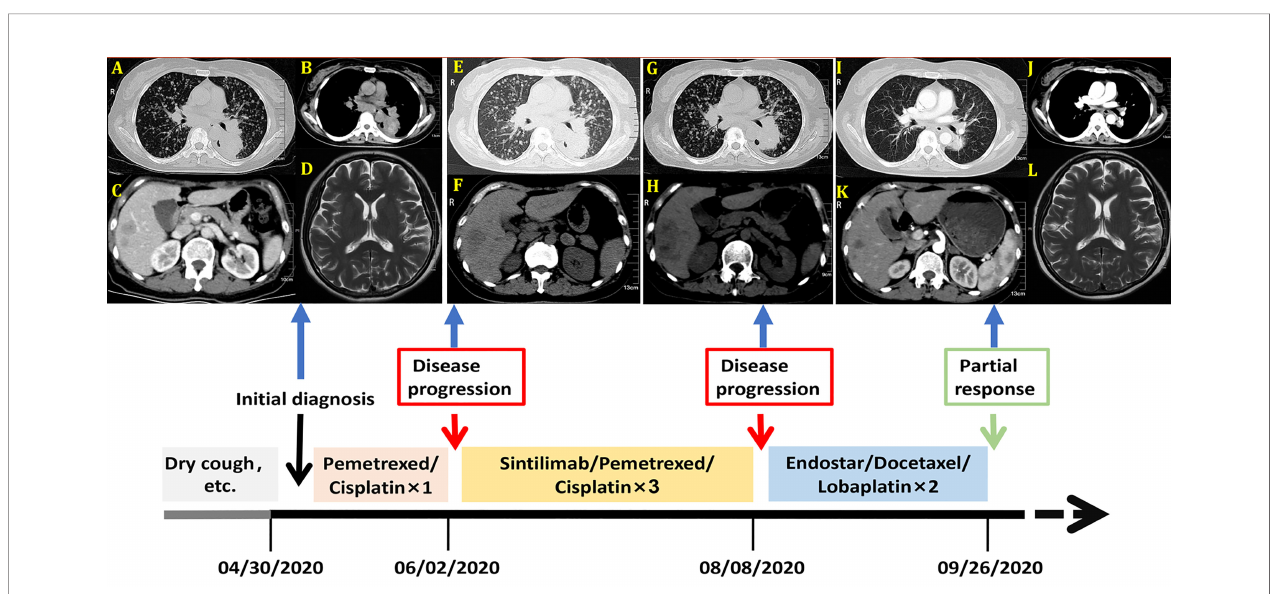
FIGURE 1 | Imagines of computed tomography (CT) and Magnetic resonance (MR) before treatment. (A) Chest CT scan with lung window; (B) Chest CT scan with mediastinal window; (C) Abdominal-enhanced CT scan; (D) Head magnetic resonance (MR) image. Imagines of CT after the fi rst cycle of pemetrexed and cisplatin. (E) Chest CT scan with lung window; (F) Abdominal CT scan; Imagines of CT after three cycles of Sintilimab combined with pemetrexed and cisplatin. (G) Chest CT scan with lung window; (H) Abdominal CT scan; Imagines of computed tomography (CT) and Magnetic resonance (MR) after two cycles of Endostar combined with docetaxel and lobaplatin. (I) Chest CT scan with lung window; (J) Chest CT scan with mediastinal window; (K) Abdominal-enhanced CT scan; (L) Head magnetic resonance (MR) image. These imagines were showed the timeline of different treatments for the patient ’ s entire treatment